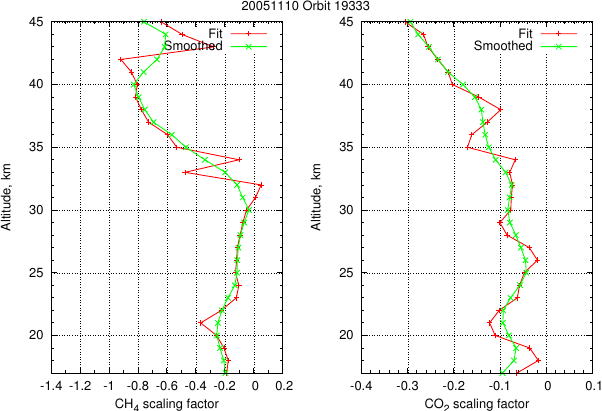
Figure 4. Example for derived profile scaling factors a from SCIA- MACHY solar occultation for CH 4 (left) and CO 2 (right). Red shows the original fit result, green shows vertically smoothed